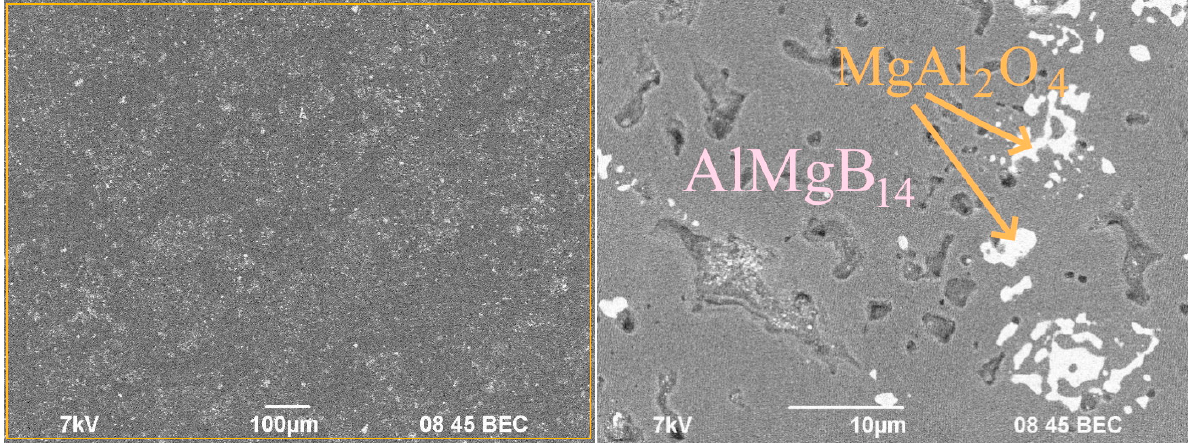
Figure 2. SEM images of the surface of the AlMgB 14 sample.